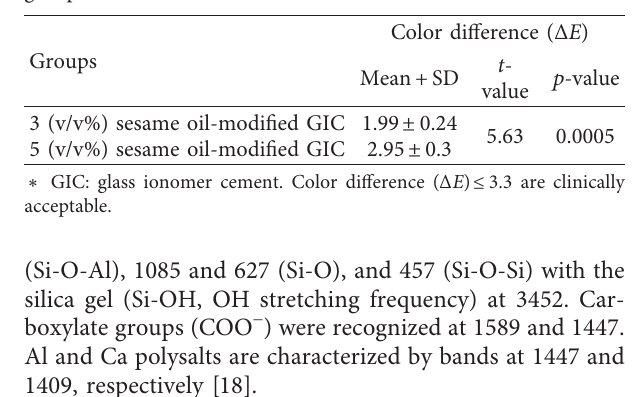
Table 2: Student t -test of the color stability results of the studied